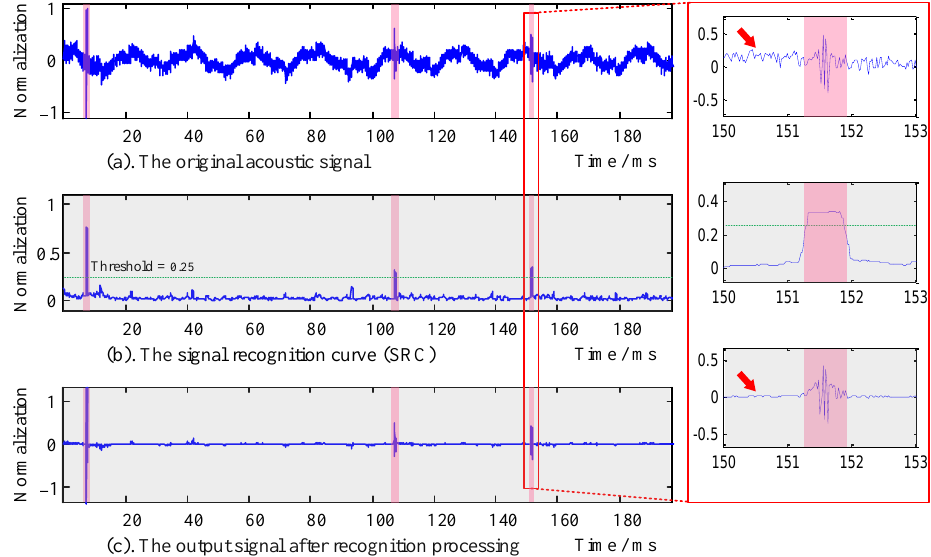
Figure 14. The SRC algorithm processing effect of the Penaeus vannamei acoustic signal.